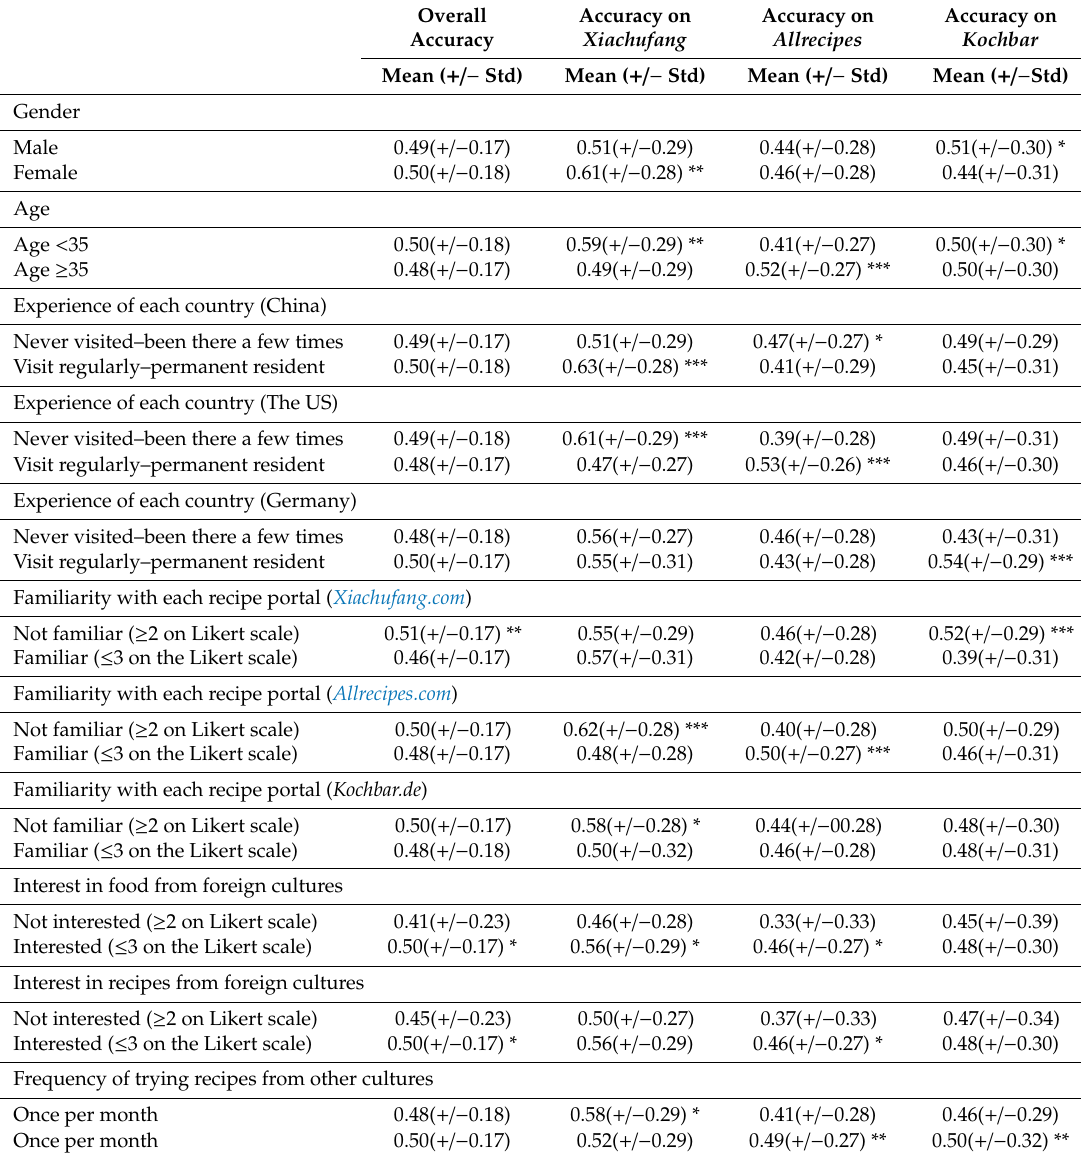
Table 8. Comparison of classification accuracy achieved by di ff erent groups based on demographic information. Only attributes with significant results are included in the table. Statistical significance across groups was determined using Mann–Whitney U tests.